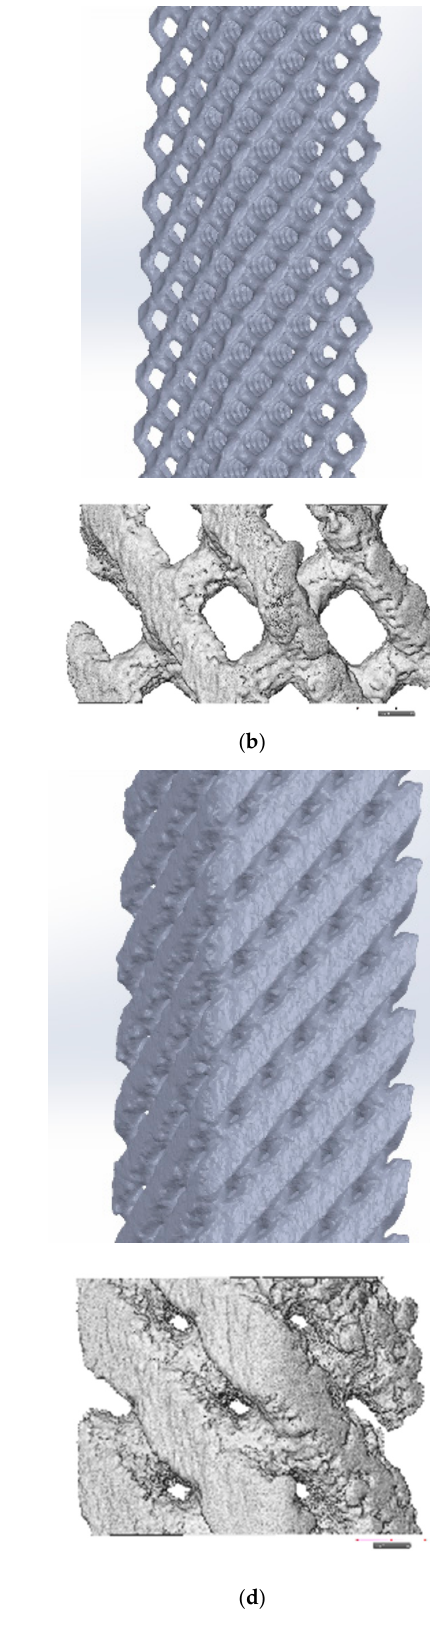
Figure 3. Spatial, tomographic and microtomographic images of the structure of samples of the Ti6Al4V titanium alloy with diamond structure and porosity: ( a ) 81%; ( b ) 73%; ( c ) 50%; ( d )